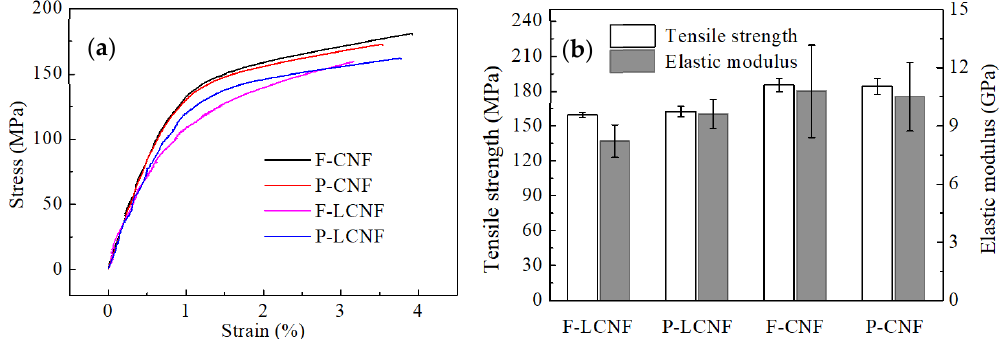
Figure 8. Typical tensile stress–strain curves ( a ) and the tensile strength and elastic modulus ( b ) of LCNF and CNF films produced from fibers and parenchyma cells.